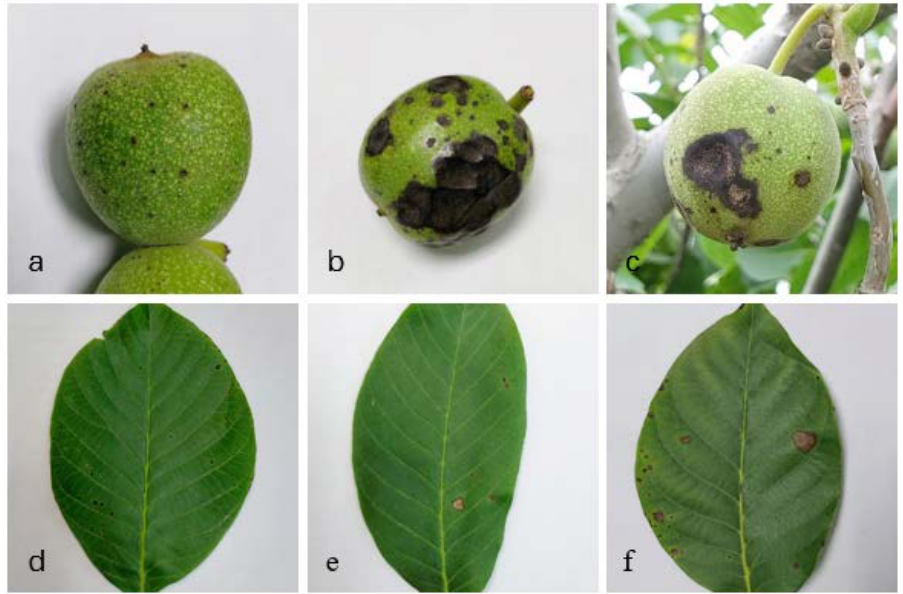
Figure 2. Symptoms of walnut anthracnose on fruits and leaves. ( a ) small black spots on fruits (diameter: <2 mm); ( b ) black sunken rot lesions on fruits (diameter: 5–35 mm); ( c ) brown necrotic lesions on fruits (diameter: 5–35 mm); ( d ) small black spots on leaves (diameter: <2 mm); ( e ) gray-brown necrotic lesions on leaves (diameter: 5–15 mm); ( f ) brown banded spots on leaves (diameter: 5–25 mm). Table 2. Disease incident rate and disease index of walnut anthracnose each month. Month Part Disease Incidence Rate (%) Disease Index June